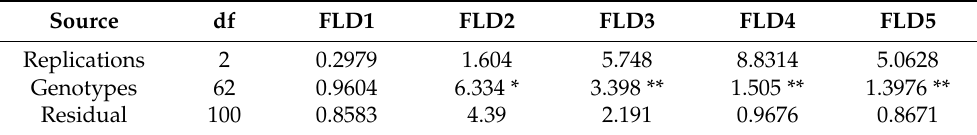
Table 7. Analysis of variance for FAW leaf damage among 63 genotypes evaluated under artificial FAW infestation in the screenhouse.